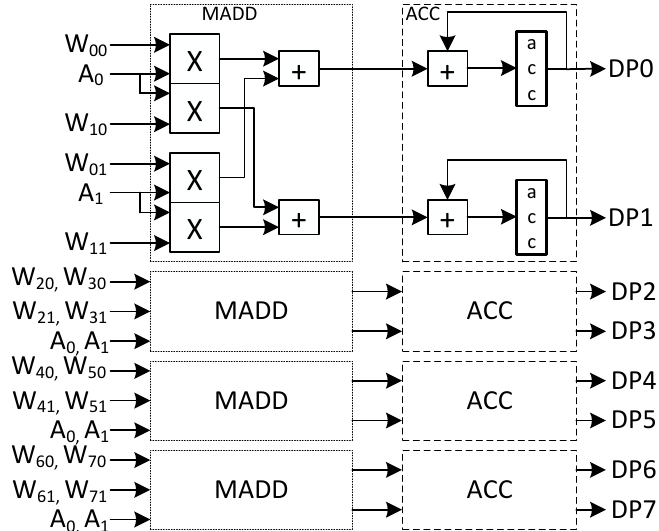
Figure 7. Architecture of a pair of cores in a line for the zero-skipping architecture with eight parallel